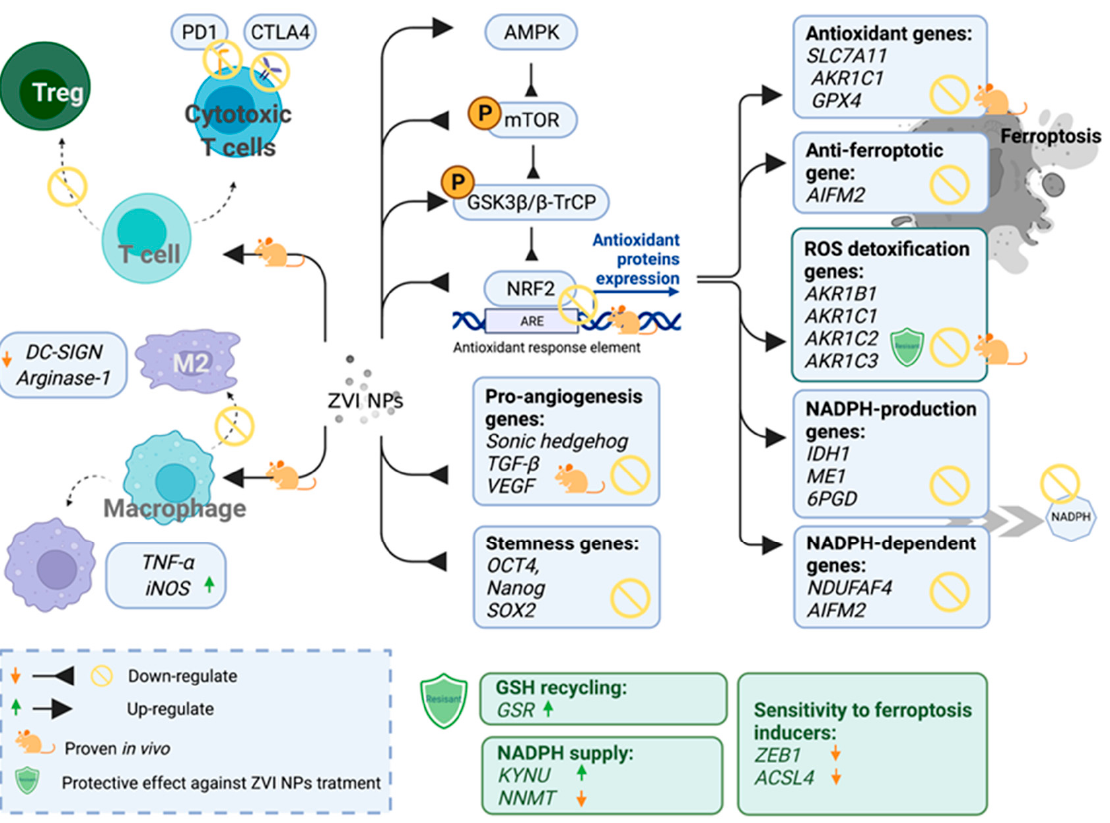
Figure 3. The overview of molecular modulation in vitro and in vivo in ZVI-based NP-treated cell and rodent models. There were several studies reporting genetic and molecular modulation under ZVI-based NPs treatment. The complex interaction and regulation of the different molecular networks involved are schematically depicted above. Created with